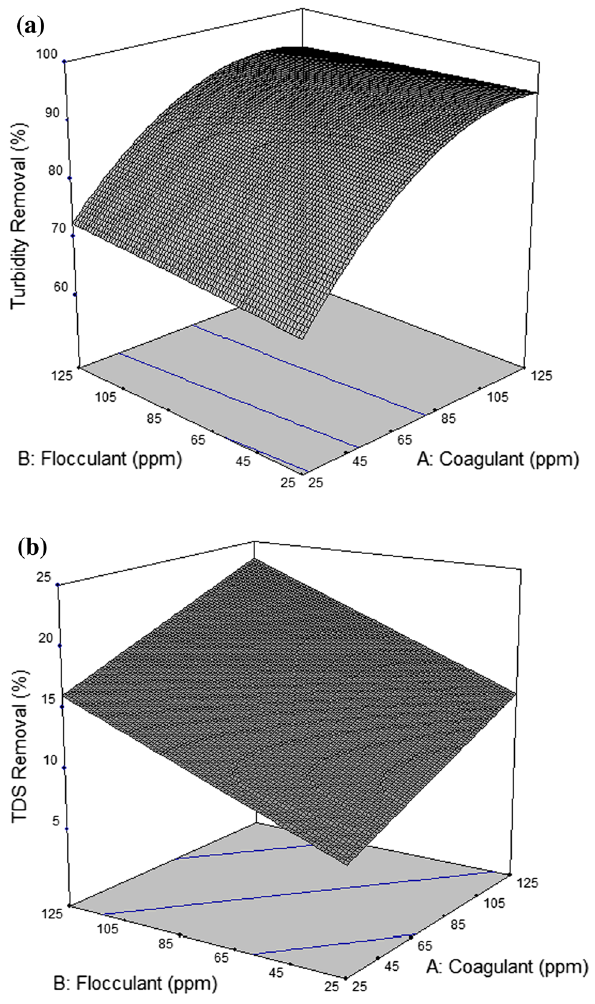
Fig. 5 Response surface plot for a Turbidity ; b TDS removal